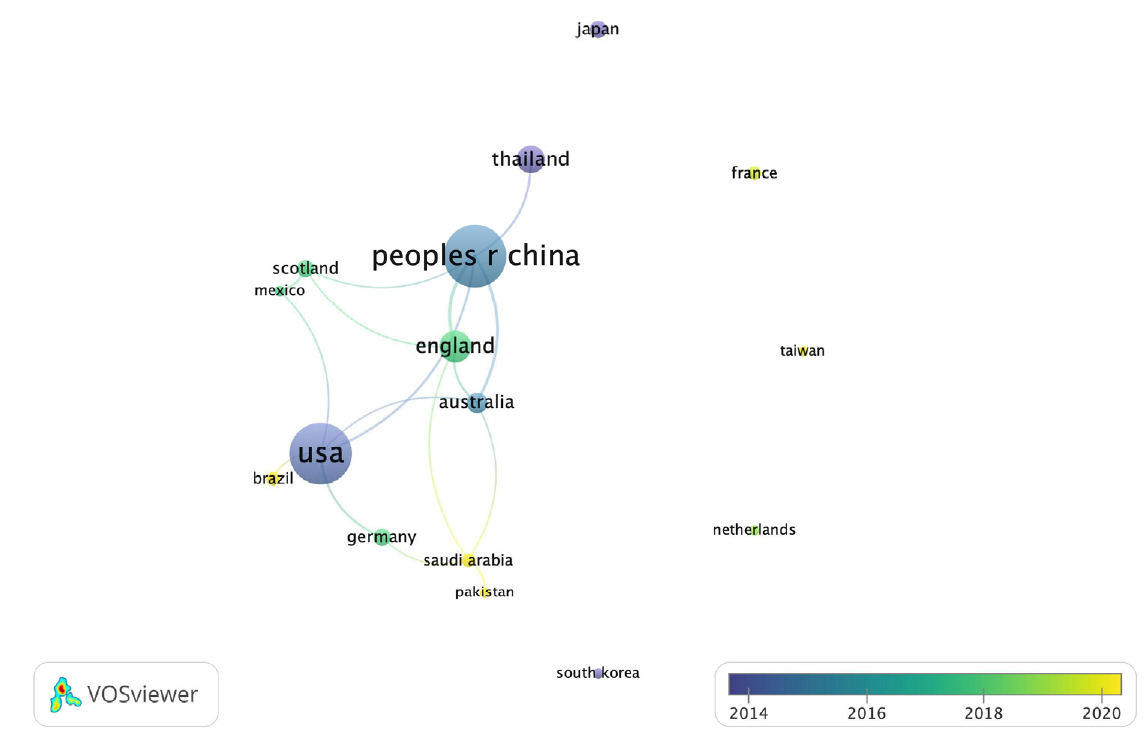
Figure 4. The co-authorship network of countries published at a minimum of three articles in overlay visualization.